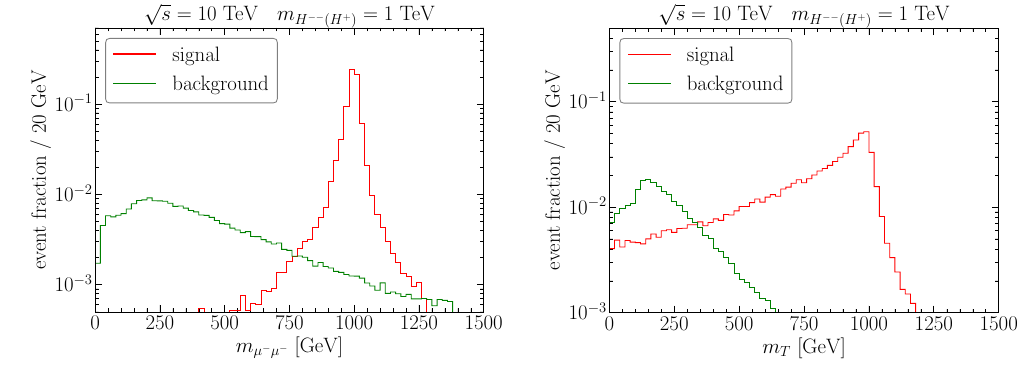
Figure 15 . The invariant mass of µ ± µ ± from H ±± → µ ± µ ± and the transverse mass m T ( µ ∓ ν ) √ from H ∓ → µ ∓ ν with = 1 TeV. s = 10 TeV and m H ±± ( H ∓ )